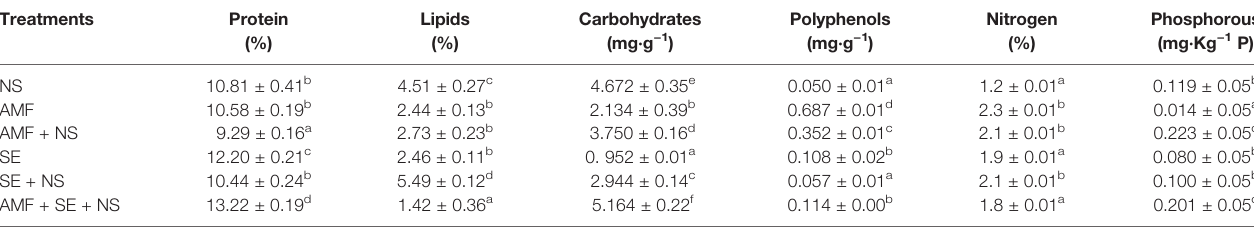
TABLE 3 | Biochemical content of tomato plants treated with plan biostimulants.